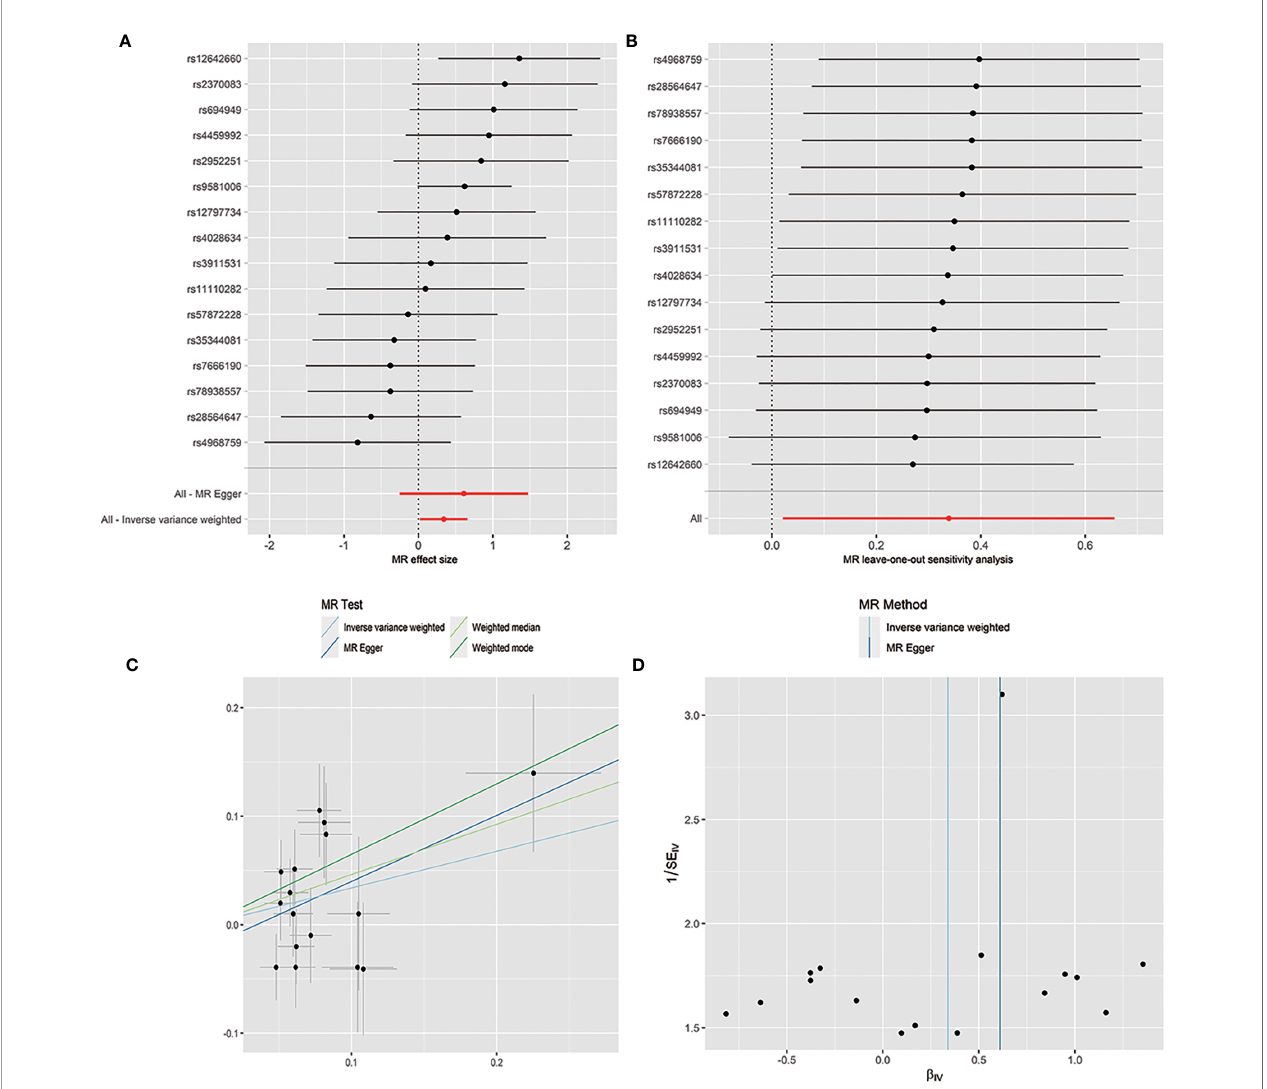
FIGURE 1 | Forest plot (A) , sensitivity analysis (B) , scatter plot (C) , and funnel plot (D) of the causal effect of Bacilli on SLE